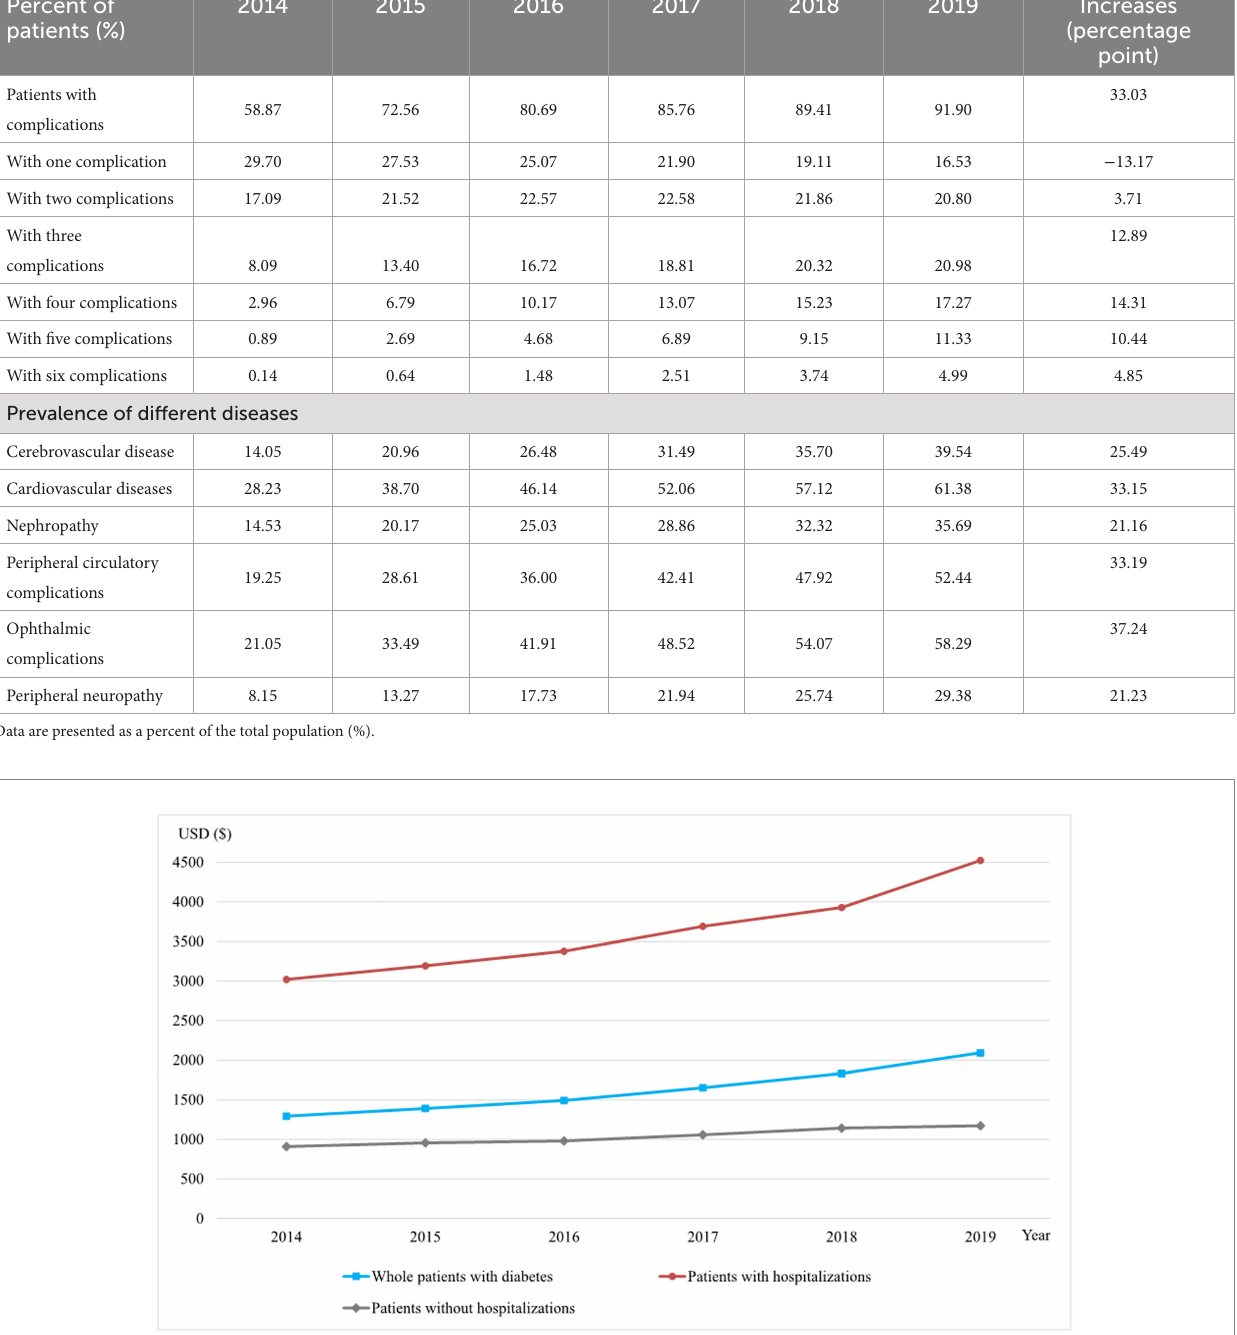
of patients without hospitalization (4,524.27 vs. 1,171.78 USD in 2019), and both increased from 2014 to 2019, with annual increases of 8.41% and 5.24% on average, respectively. The DM costs for patients in all complication groups showed a gradual upward trend from 2014 to 2019 (Figure 2). The DM costs of patients without complications were all lowest and almost unchanged during 2014–2019 (with an AAGR of 0.98%). Patients with